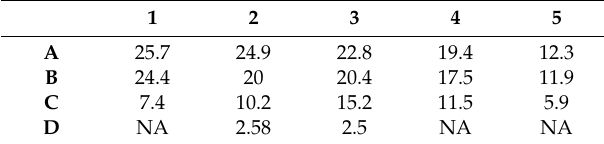
Table 2. SNR related to raw data captured by step heating thermography (cooling Table 3. SNR related to raw data captured by flash thermography.